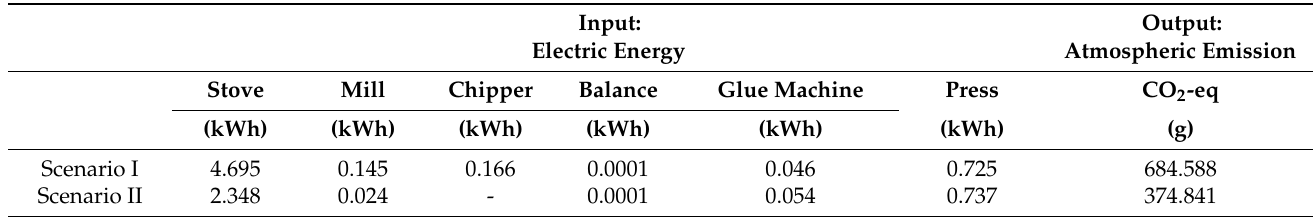
Table 2. Inputs and outputs of the MDP production for the two scenarios.